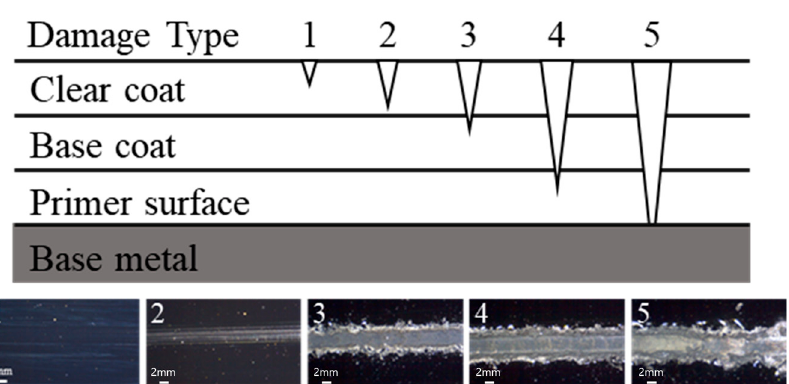
Figure 1. Scratch damage types of automotive coating identified using 1 mm tip at scratch speed of 100 mm/s.